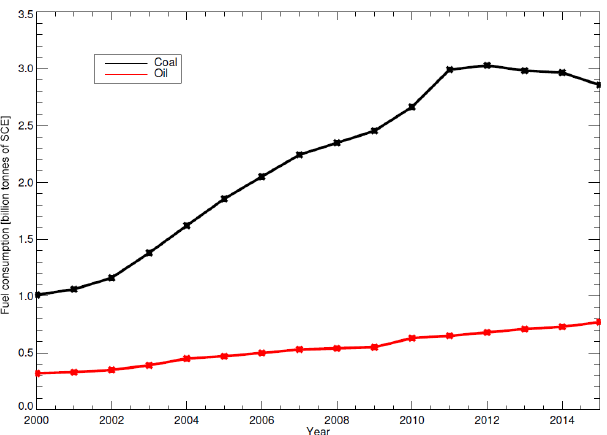
Figure 7. Time series of the ratio of the mean SO 2 columns and the fossil fuel consumption in China based on observations of OMI (black), SCIAMACHY (green), and GOME-2 (blue). The ratios of the annual NO x emissions and the fossil fuel consumption are based on observations of OMI (red). All time series are normalized to the year